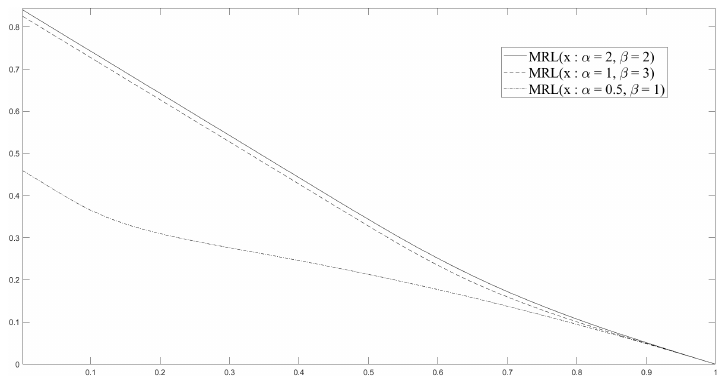
Figure 4 – Mean residual life functions of unit-Gompertz distribution for ( α = 2, β = 2 ) , ( α = 1, β = 3 ) & ( α = 0.5, β = 1 )